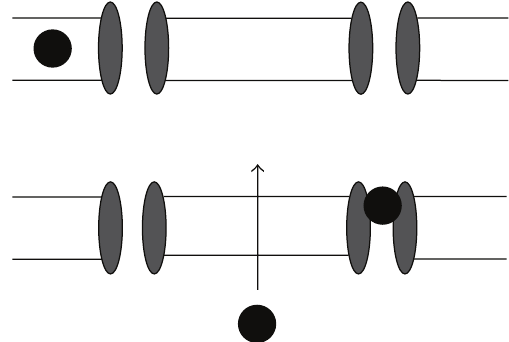
Figure 1: Mechanism of action of local anesthetics. Unionized LA enters nerve axon and becomes ionized to block sodium channels. LA also has direct e ff ects by expanding the cell membrane to increase fluidity.